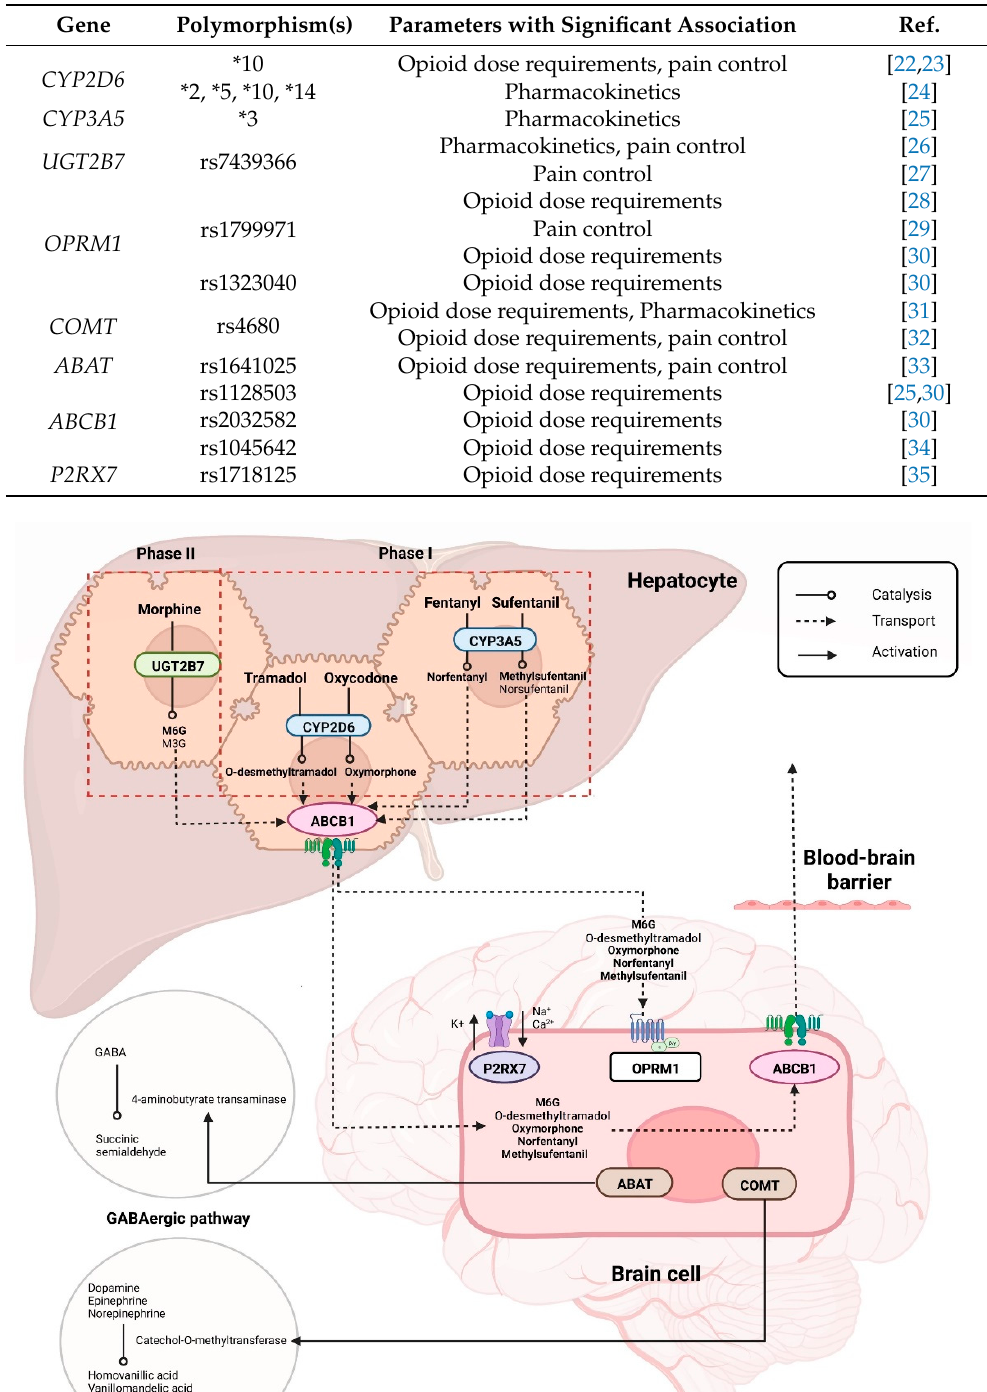
Table 1. List of genes reported with significant associations in Asian populations.